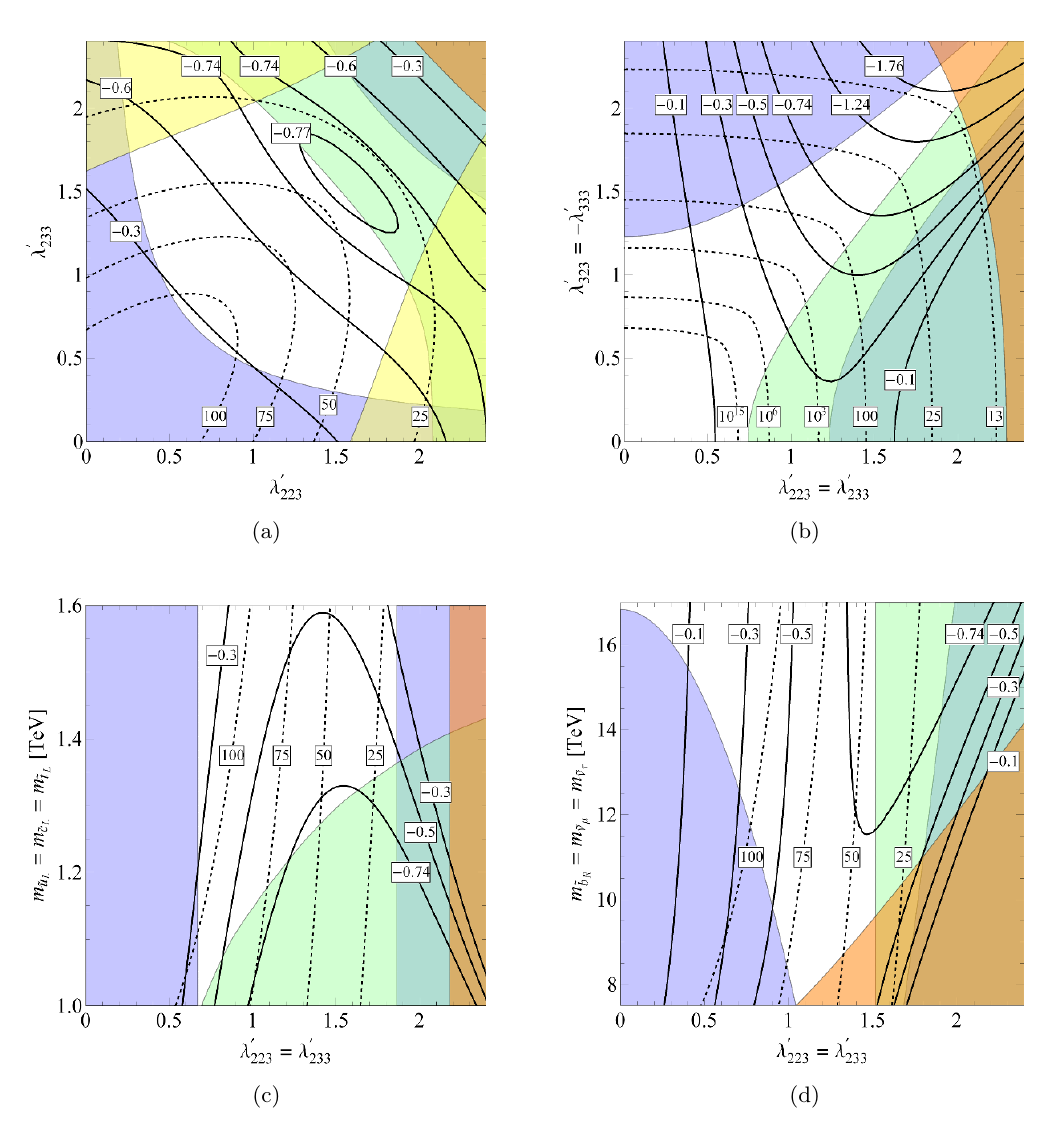
Figure 6 . Four example (cid:12)gures showing solid contours of C (cid:22) . For (cid:12)gure 6(a), we set (cid:21) 0 = 323 LL (cid:0) (cid:21) 0 = 1 : 4, m ~ = 300 GeV, m ~ u = m ~ c = m ~ = 1 : 3 TeV, and m ~ = m ~ (cid:23) = m ~ (cid:23) = 13 TeV. 333 t L W b R (cid:22) (cid:28) L L For (cid:12)gure 6(b), the masses are set to the same values as in (cid:12)gure 6(a). For (cid:12)gures 6(c) and 6(d), (cid:21) 0 , (cid:21) 0 , and the masses not being varied are again set to the values used in (cid:12)gure 6(a). Dashed 323 333 contours show energy scales of Landau poles in TeV. Parameter space excluded by (cid:28) ! (cid:22)(cid:22)(cid:22) is shown in yellow. Parameter space excluded by B s (cid:0) (cid:22) B s mixing is shown in blue. Parameter space excluded by B ! K ( (cid:3) ) (cid:23) (cid:22) (cid:23) is shown in orange. Finally, parameter space excluded by direct LHC searches is shown in